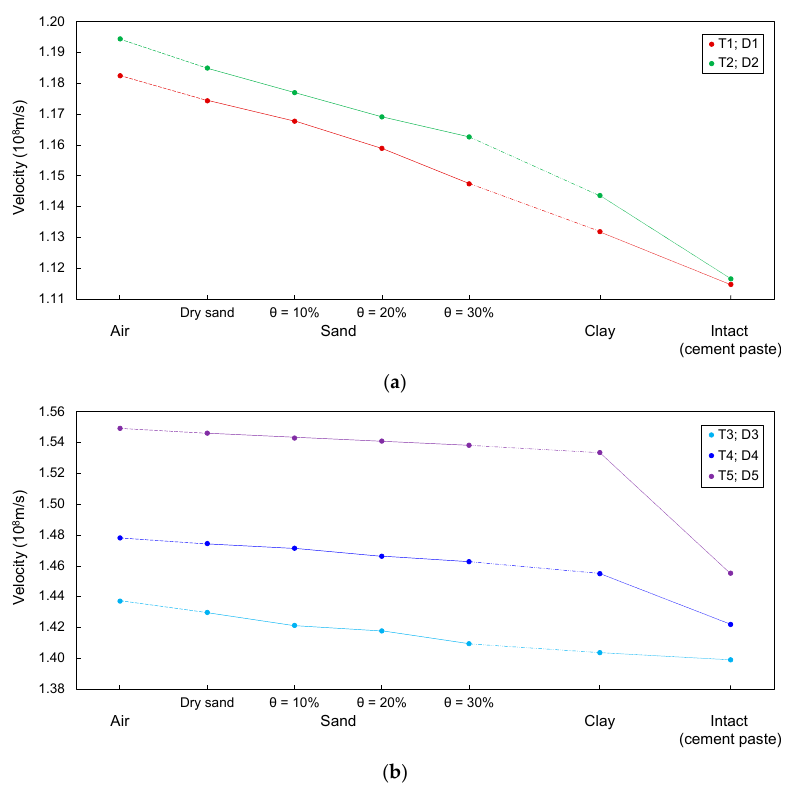
Figure 13. Variation in the velocity of electromagnetic waves according to different materials filling defects: ( a ) T1; D1 and T2; D2 and ( b ) T3; D3, T4; D4, and T5; D5.